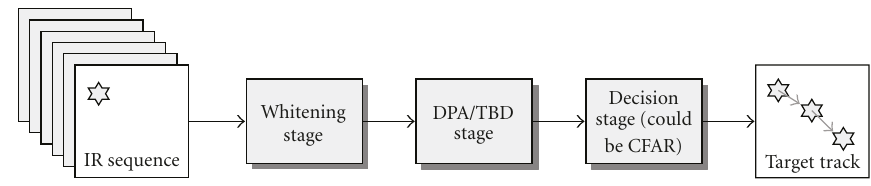
Figure 1: Tracking system